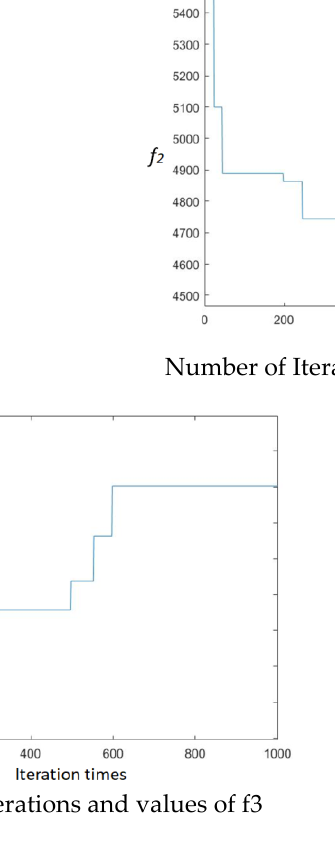
Figure 5. Relation between the Number of Iterations and function values.